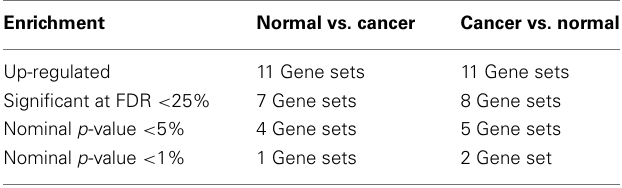
Table 2 | Summary of gene set enrichment analysis (GSEA) results for the colorectal cancer (CRC) related microarray – GSE8671, based on the 36 gene sets searched from GeneSigDB by using query term – “colon.”